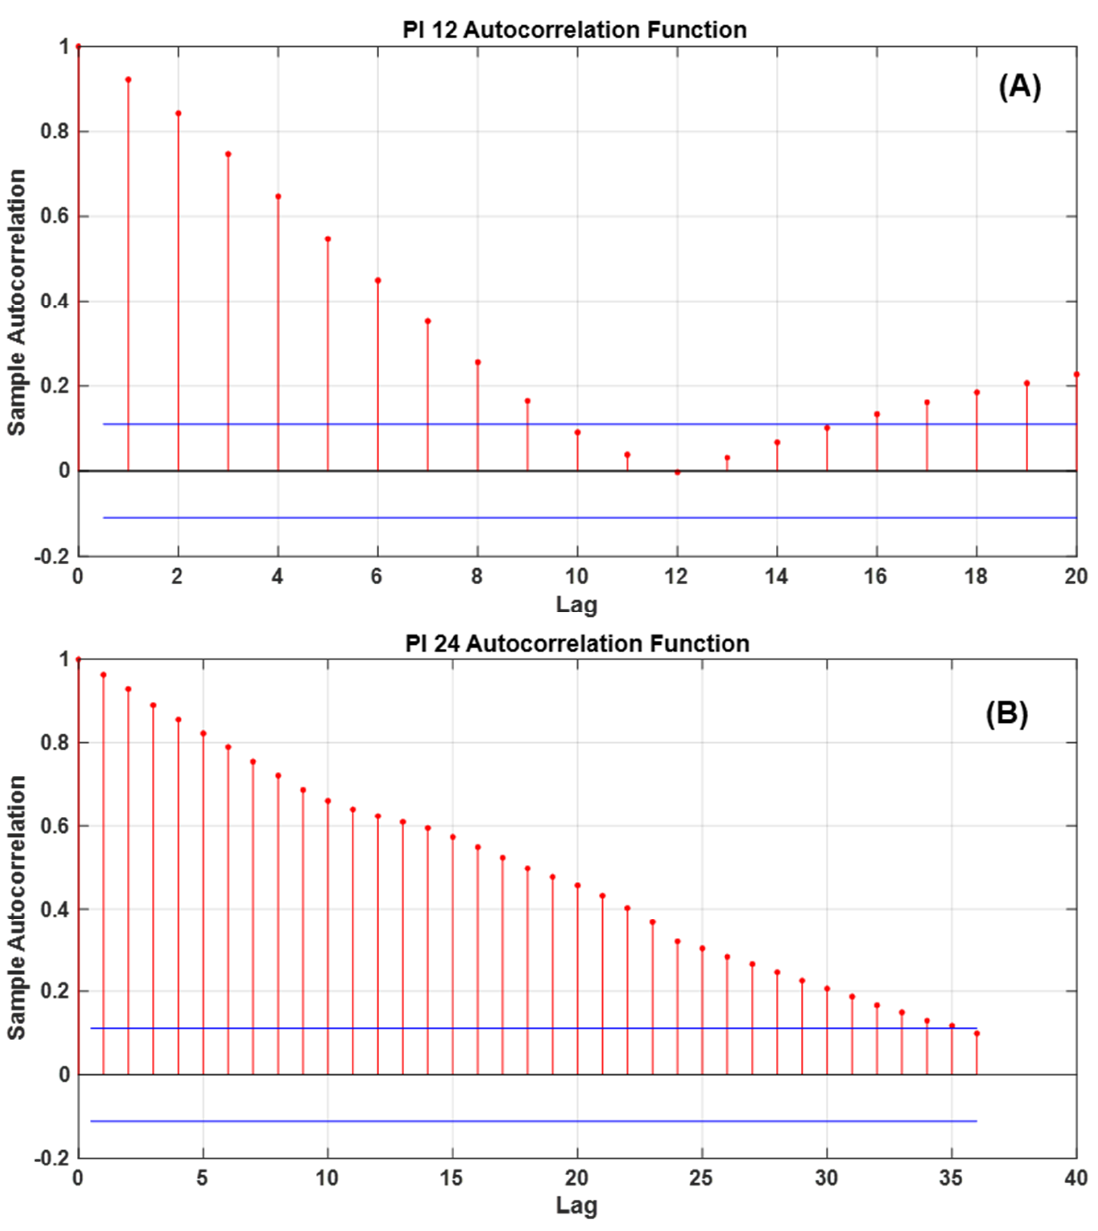
Figure 5. Correlogram test results for the ( A ) 12-month and ( B ) 24-month observed precipitation index time series for the study area.